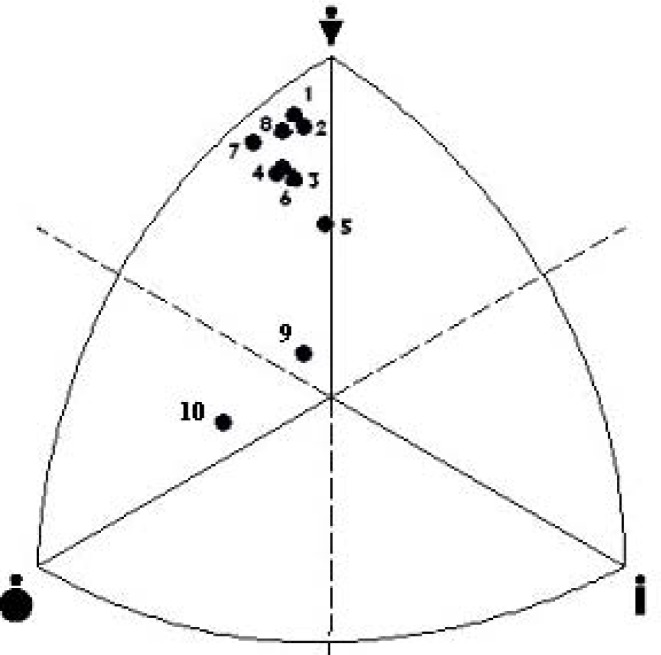
Somatotypes of Greco-Roman wrestlers: 1- POL This study → endomorphic mesomorph; 2- Cuba, Betancourt, 2002 → endomorphic mesomorph; 3-POL 1993-95, Krawczyk et al., 1997 → endomorphic mesomorph; 4-POL seniors 1994, Skład et al., 1995 → endomorphic mesomorph; 5-POL juniors 1994, Skład et al., 1995 → balanced mesomorph; 6-POL 1990, Charzewski et al., 1991 → endomorphic mesomorph; 7- Cuba 1976–80, Rodriguez et al., 1986 → endomorphic mesomorph; 8- Czechoslovakia 1973, Stepnicka et al., 1976. → endomorphic mesomorph; 9-Untrained subjects, Piechaczek, 1998 → endomorphic mesomorph; 10-Phantom, Ross and Ward, 1974 → mesomorphic endomorph.